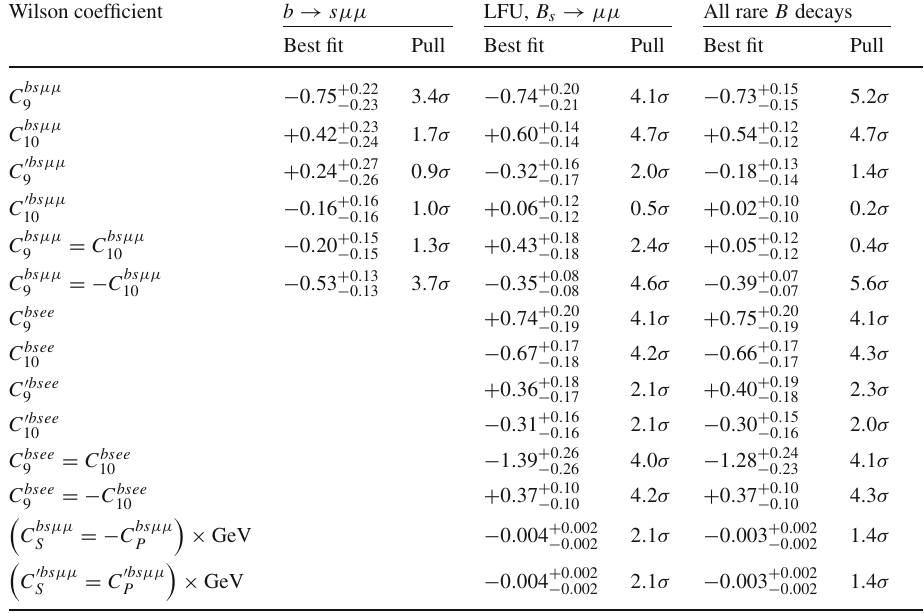
Table 1 Best-fit values with corresponding 1 σ ranges as well as pulls in sigma between the best-fit point and the SM point